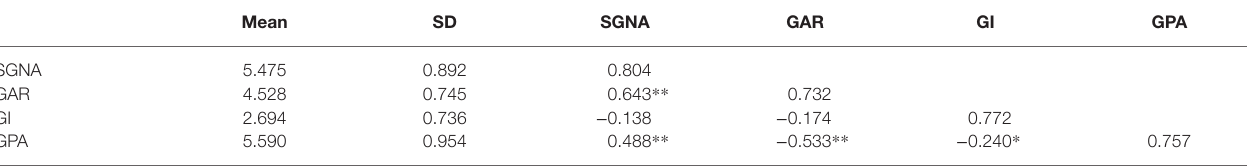
TABLE 3 | Means, standard deviations (SDs), and